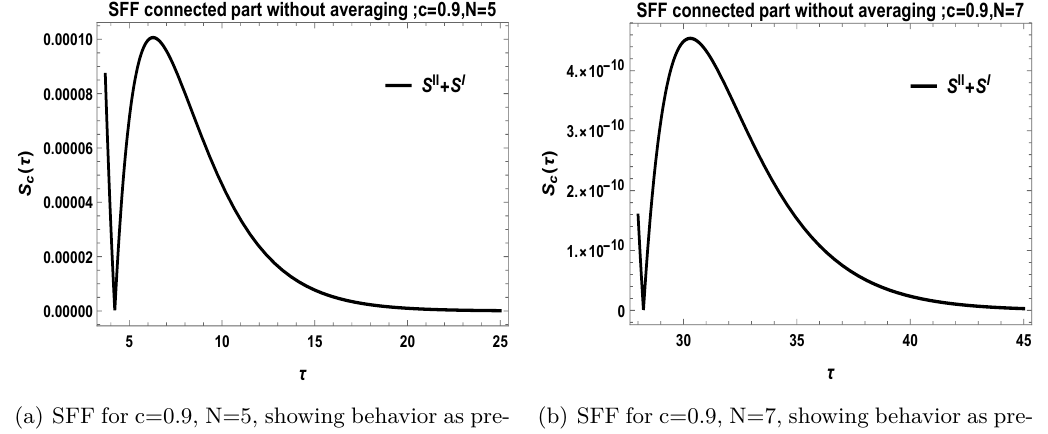
Figure 4 . SFF of connected part S c ( S I + S II ) from eq.